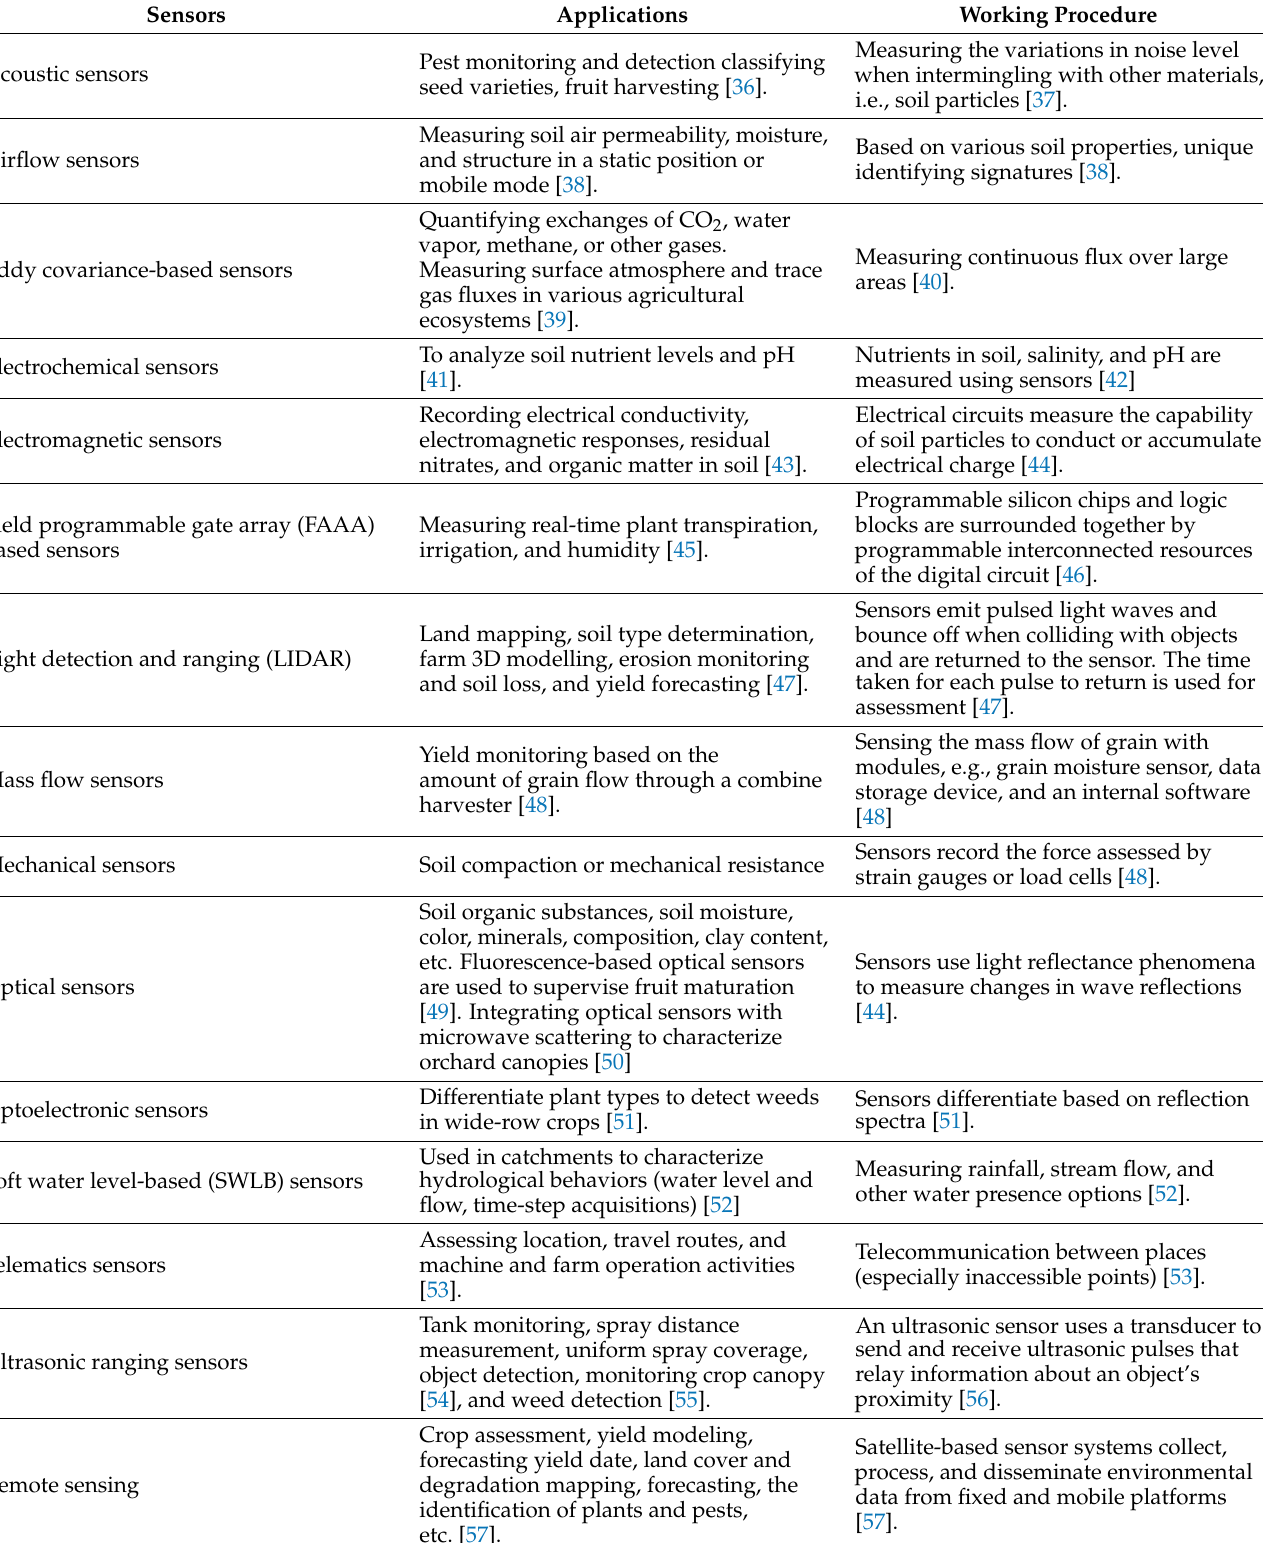
Table 1. Sensor types and their